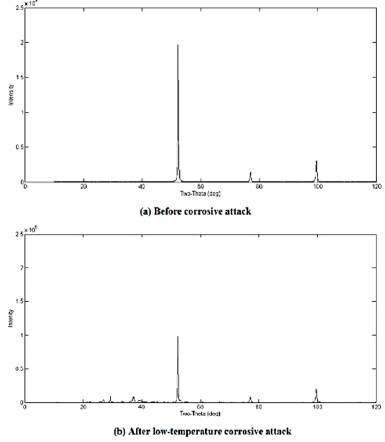
Figure A22. Cont